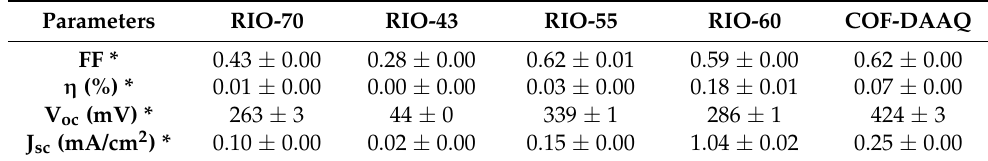
Figure 9. Photocurrent–voltage (J–V) curves of DSSCs based on ( a ) the starting materials and the use of N719 as dye after adsorption for 5 h, ( b ) the starting materials, ( c ) the starting materials without TFPG. Tests were conducted under simulated AM 1.5 G illumination at 100 mW/cm 2 . Table 2. Photovoltaic performance parameters of DSSCs based on COFs RIO-60 as a dye replacement. The second-best result was obtained for BBY, which is a dye that is commonly used for photochemical and photoelectrochemical applications. From all of the starting materi- The initial assessment was conducted under simulated AM 1.5 G illumination at 100 mW/cm 2 . ( The als tested, DAPSO had the poorest performance. presented results correspond to the best-performing cell ). Table 2 and Figure 10 present the results for the COFs used as dyes in DSSCs. Despite being successfully adsorbed onto the TiO 2 -anode, the results obtained for RIO-43 were not